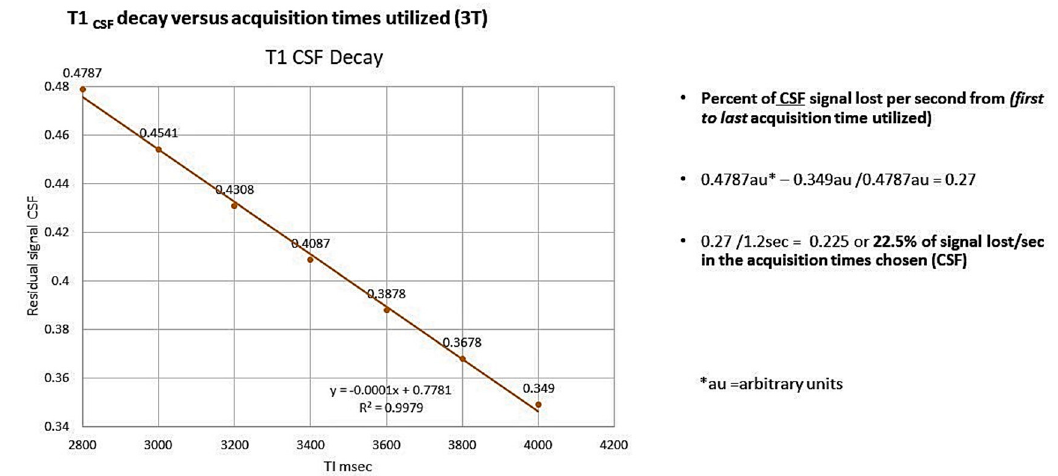
Figure A2. Linear regression of the calculated T1 CSF versus acquisition times used. Note the slope is within the range of the normal subjects and R 2 showing high correlation as plotted.